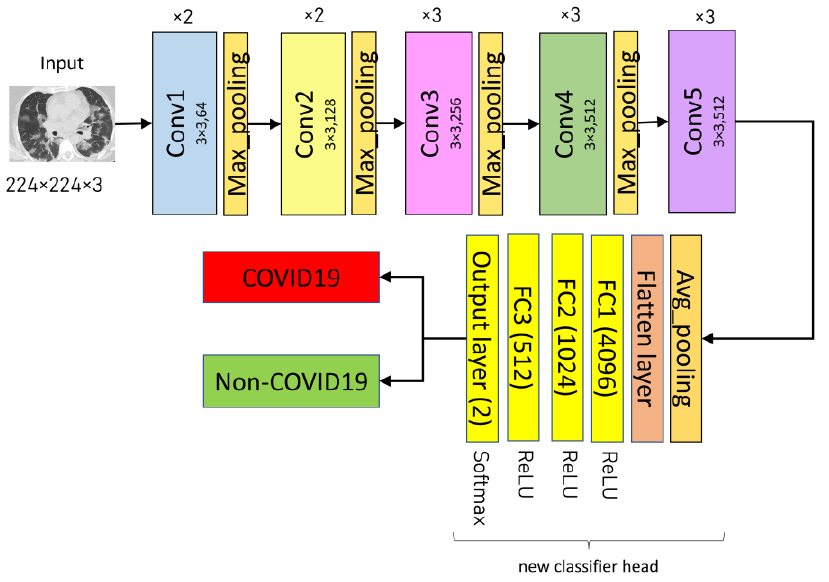
Figure 6. Architecture of the proposed VGG16 model.